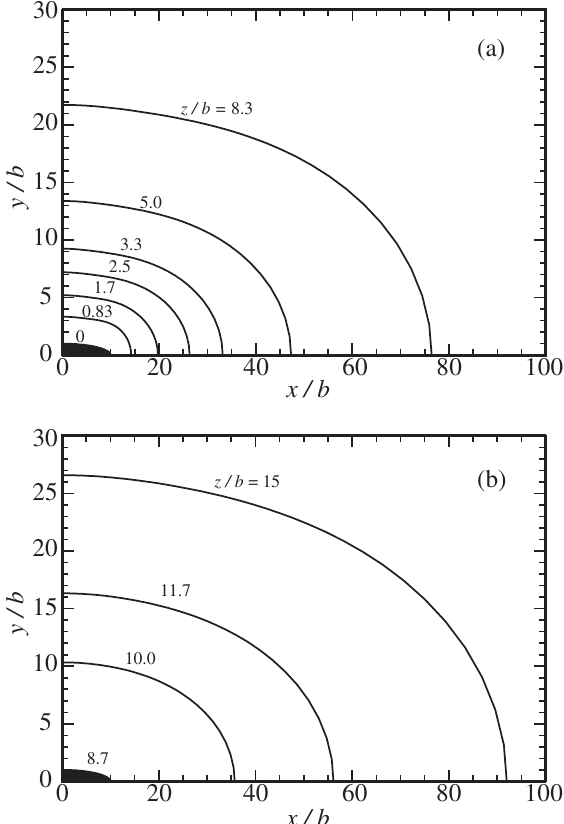
FIG. 3. Level curves of (a) (cid:1) (cid:7) 0 and (b) (cid:1) (cid:7) (cid:1) surfaces for d a 10:1:8.7 space-charge-limited elliptical diode of semimajor radius 10 b , semiminor radius b , and length 8 : 7 b . The beam fills the shaded area, which is intersected by the (cid:1) (cid:7) 0 surface at z (cid:7) 0 and the (cid:1) (cid:7) (cid:1) surface at z (cid:7) 8 : 7 b d